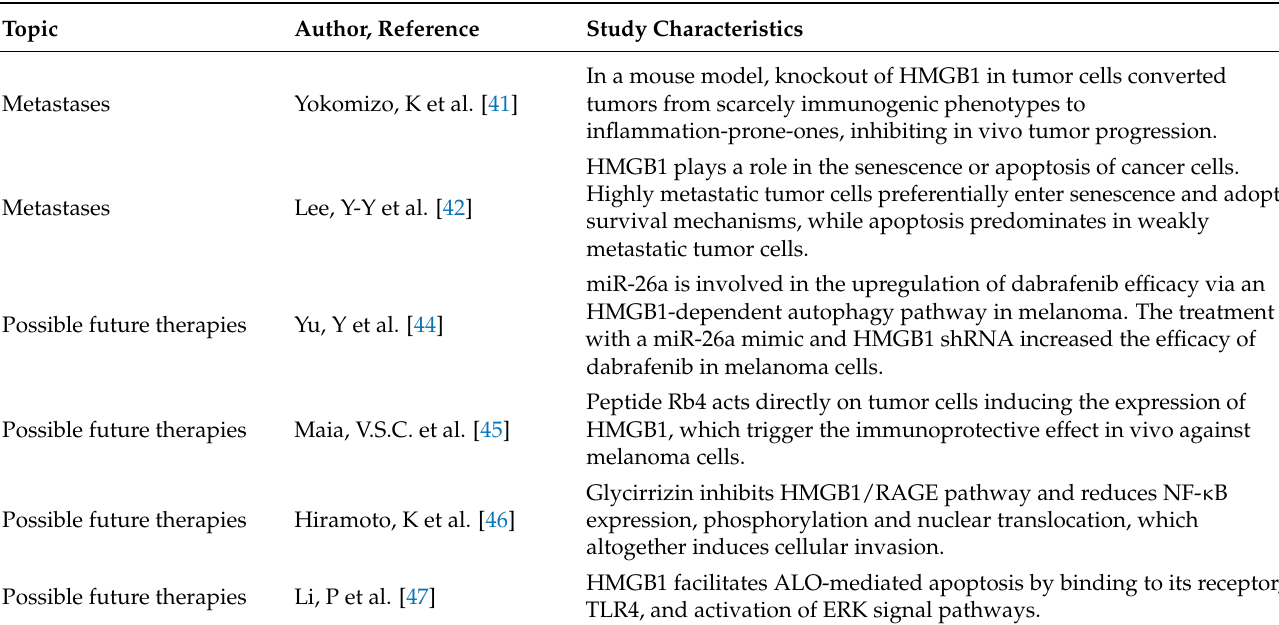
Table 1. The role of HMGB1 in metastasis process and possible future